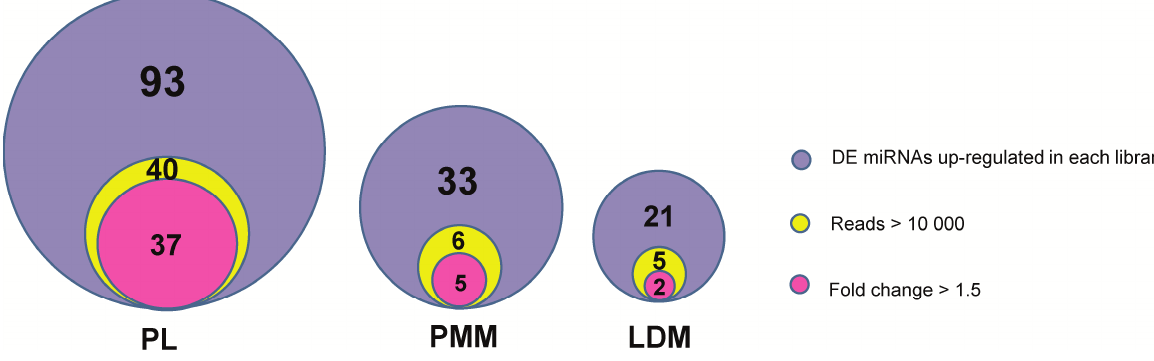
Figure 3. Distribution of differentially expressed miRNAs among three